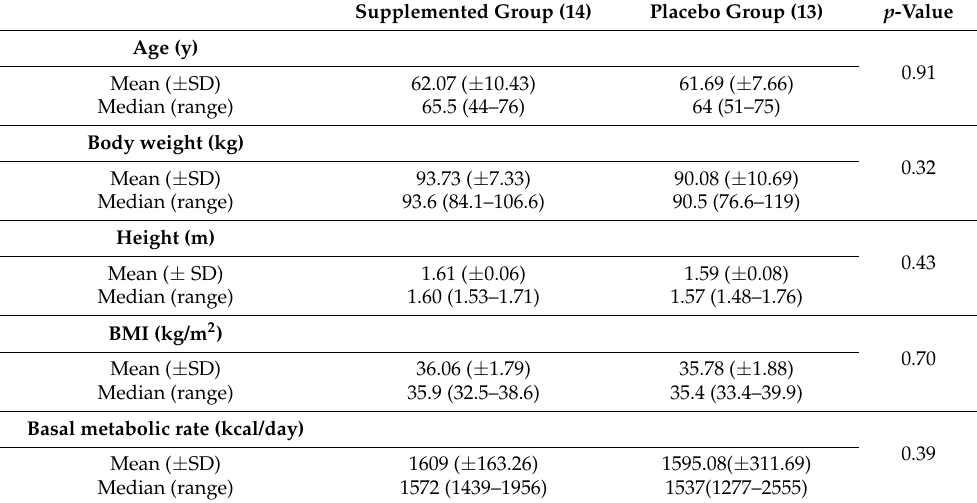
Table 2. Age, body weight, height, BMI, and basal metabolic rate values at baseline for the supple- mented and placebo